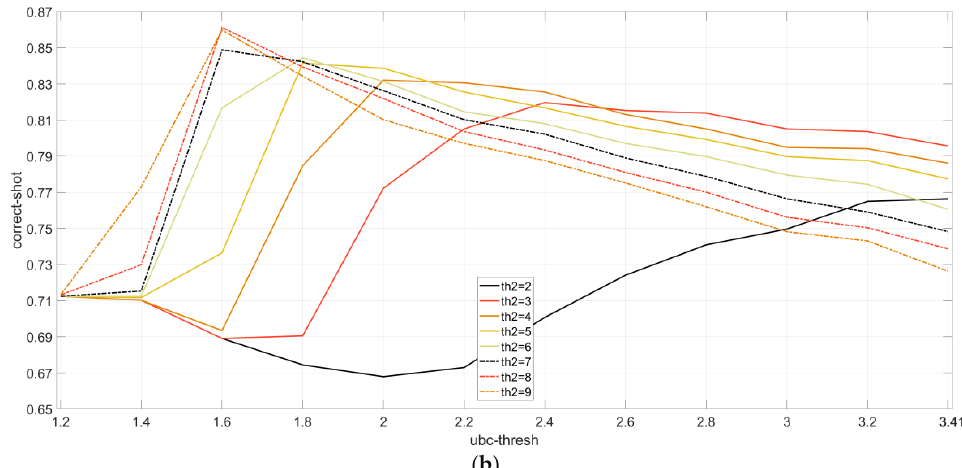
Figure 17. The experimental results by using different size images. ( a ) Video searching; ( b ) Shot searching.